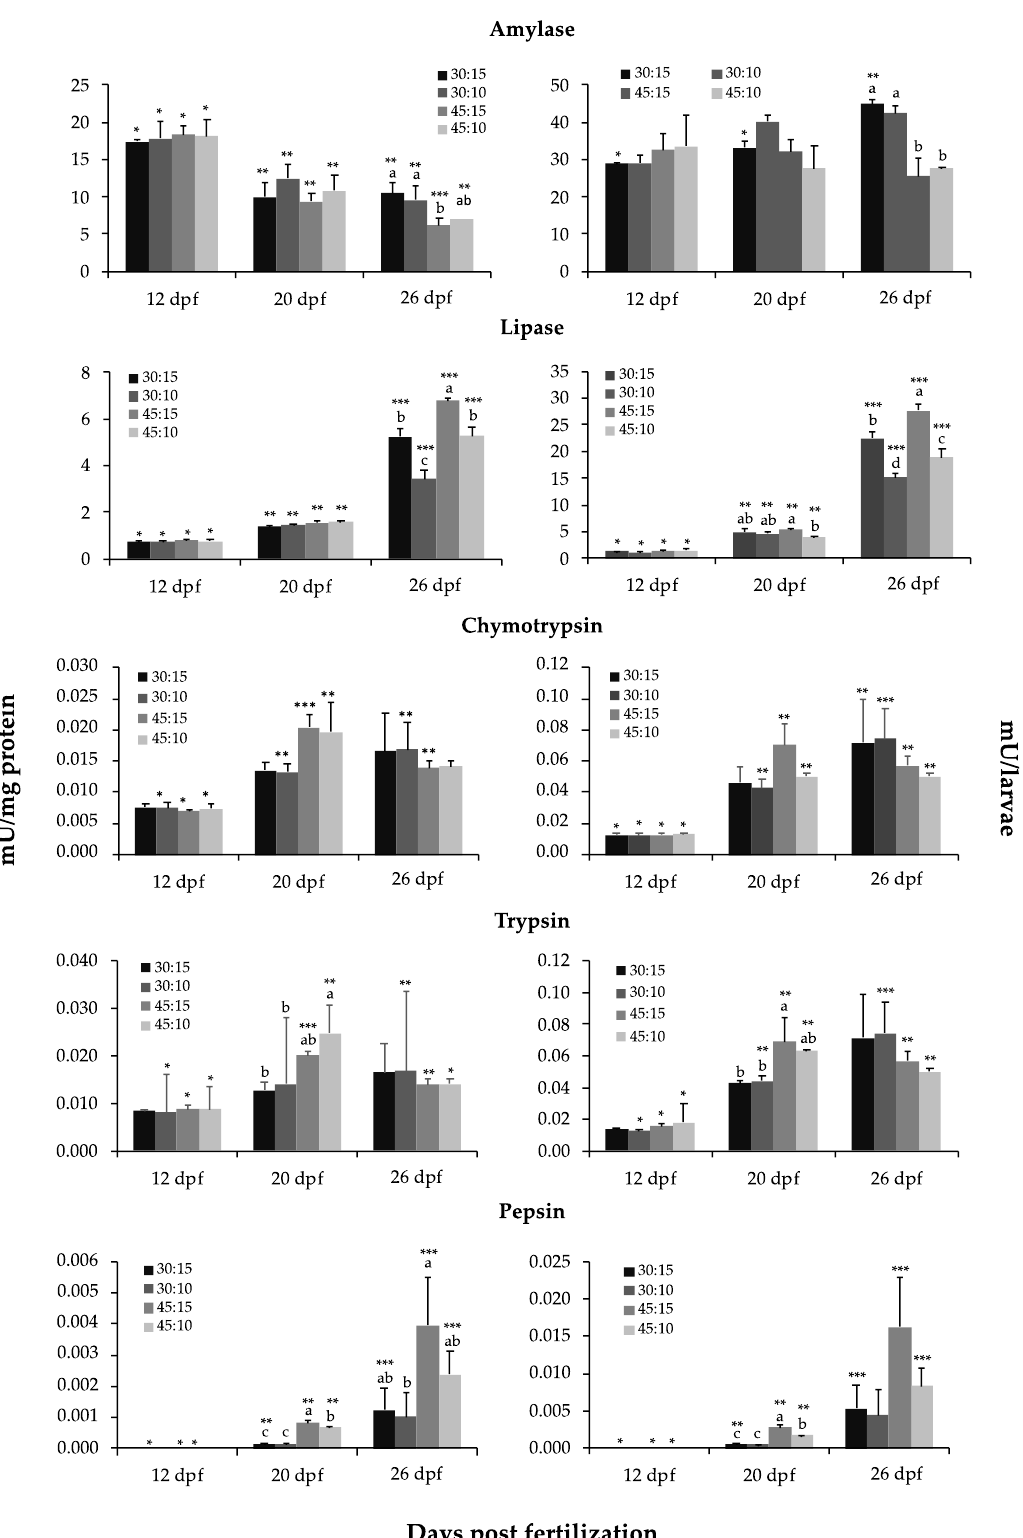
Figure 4. Specific (mU mg − 1 protein, on the left) and total (mU larva − 1 , on the right) activity of α -amylase, bile salt-activated lipase, chymotrypsin, trypsin, and pepsin in P. punctifer (12, 20, and 26 dpf) fed the different experimental diets containing different protein:lipid levels (in % of dry matter). Data are represented as means ± S.D. ( n = 3). Values with a different superscript letter denote significant differences between dietary groups of the same age, and values with a different number of asterisks indicate significant differences between days for the same dietary treatment (one-way ANOVA, p < 0.05).